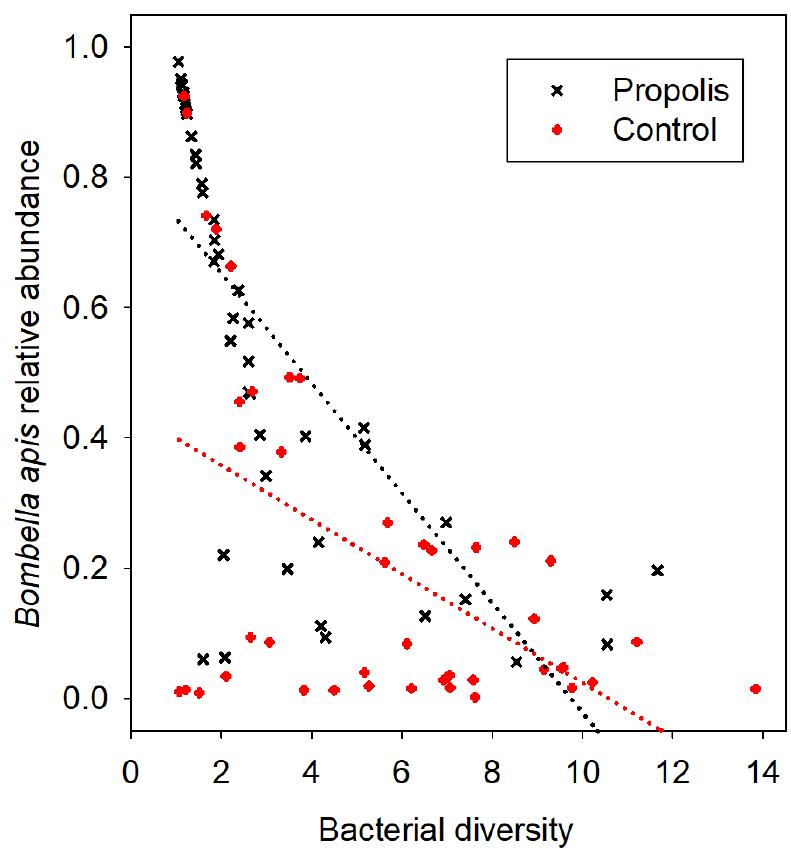
Figure 2. The primary e ff ect of propolis in restructuring the mouthpart microbiome. The y -axis shows the variation in the relative abundance of the dominant mouthpart bacterium ( Bombella apis ). The x -axis is the total mouthpart diversity (inverse Simpson), where an increased value represents an increased diversity, and the di ff erent symbols represent propolis addition or no propolis addition (control). Considering both states, the relationship was significantly negative, but compared to the control, the relationship with added propolis explains significantly greater variation between the dominant bacterium and the diversity of the mouthpart microbiome. Linear regression of the relative abundance of Bo. apis with inverse Simpson values; propolis: adjusted R-sq = 0.5, p < 0.0001, and control: adjusted R-sq = 0.25 p = 0.0003.